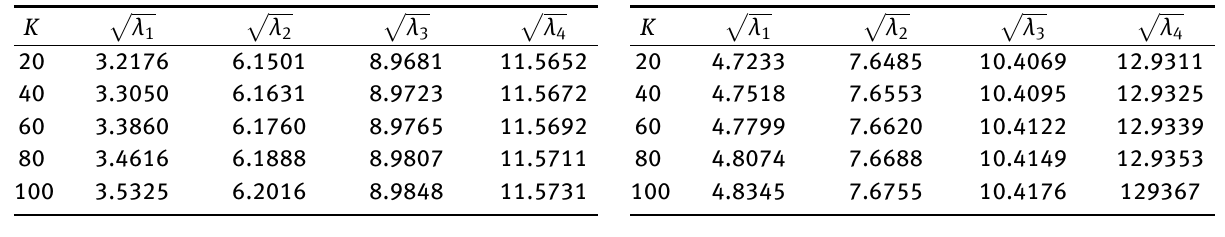
(︁ √ )︁ for CS nanobeam for different λ